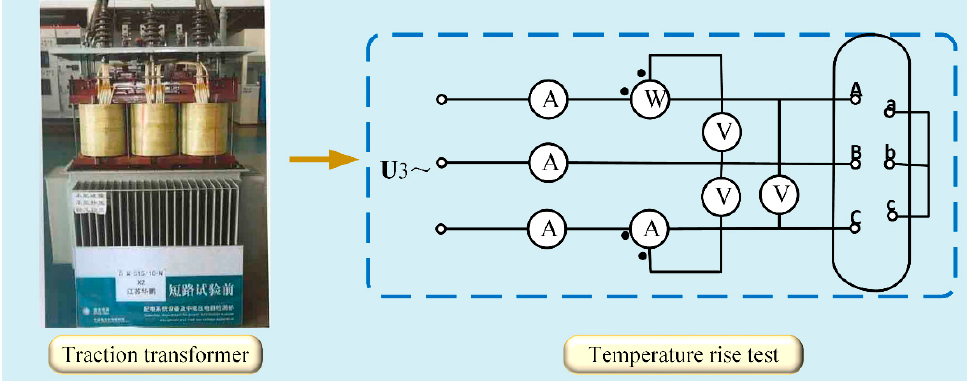
Figure 7. Design of S-M-315/10-NX2 distribution transformer.